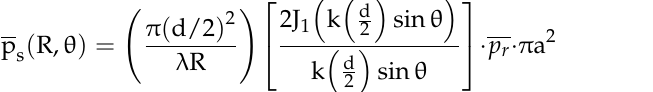
Figure 6. The calculation of the echo sound pressure received by the transducer. R (cid:2933)(cid:2917) and R (cid:2933)(cid:2922) represent the reflection coefficients at two parts of the circle section, respectively. Assuming that the total area of the circle section is A , the area above the liquid level is expressed by A (cid:2915) , and let r (cid:2929) = A (cid:2915) A⁄ , the ratio r (cid:2929) can be calculated by Equation (4). r (cid:2929) = 1 π (φ − sin φ cos φ) (4) where φ is the angle between the line OC and the Y-axis and 0 ≤ φ ≤ π , C is a cross point of the circle section and the liquid level, O is the center of the circle section. In the cross section of the beam, the energy is mainly concentrated at the inner surface of the container wall; part of the beam will propagate into the container, the other part of the beam will be reflected because of the discontinuous impedance, which follows the reflection principle of the sound wave. When 0 ≤ ∆d ≤ d , the circle section is divided into two parts by the liquid level; the echo sound pressure received by the transducer should be calculated by superimposing the two parts of the circle section. It is assumed that the reflected echoes in the wall will decay to a very small amount after n times, which can be neglected relative to the total energy received by the receiving transducer.